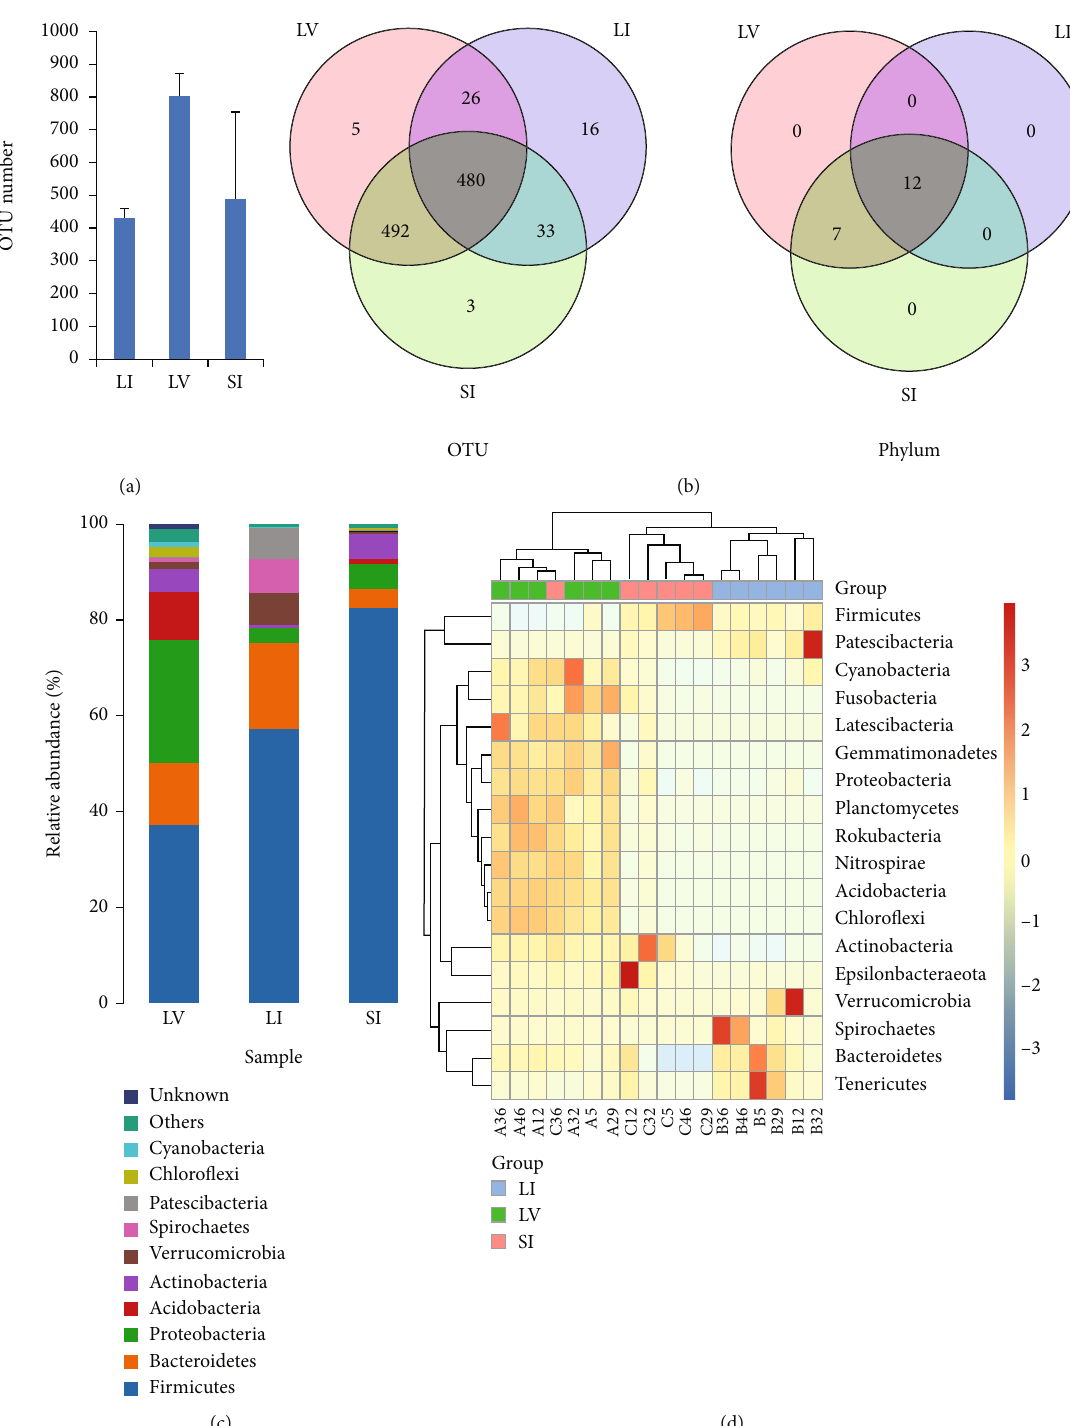
Figure 4: OTU distribution and taxonomy in the liver, ileum, and feces. (a) OTU distribution of samples. (b) Venn diagram of phyla shows shared and exclusive bacteria. (c) Species distribution (phyla). (d) Abundance heat map (phyla). Bacterial abundance: top 20; abundance ratio > 1 % ; distance calculation, Euclidean; cluster calculation, complete. LV: liver; LI: large intestine (feces); SI: small intestine